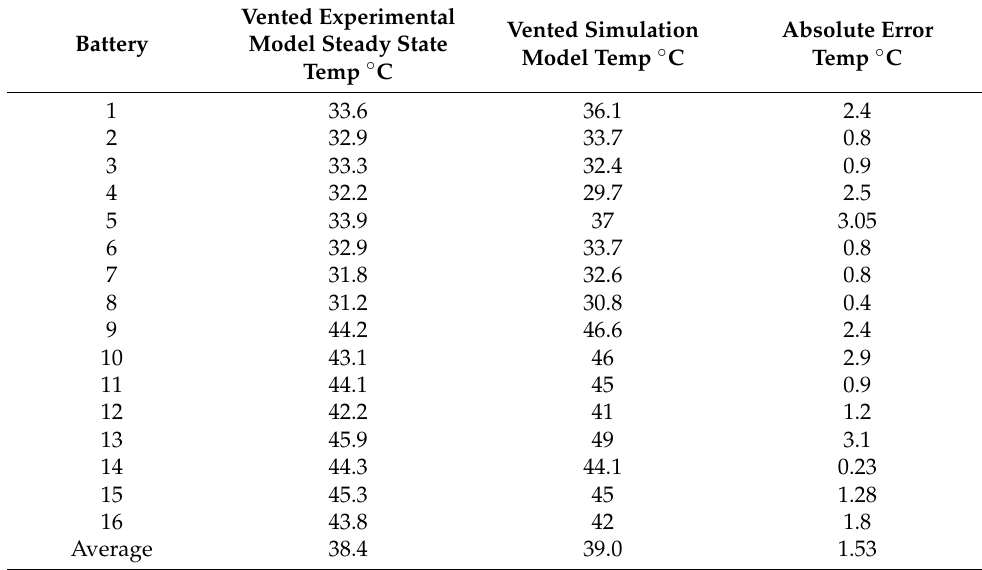
Table 5. Vented design experimental and simulation temperature comparison.